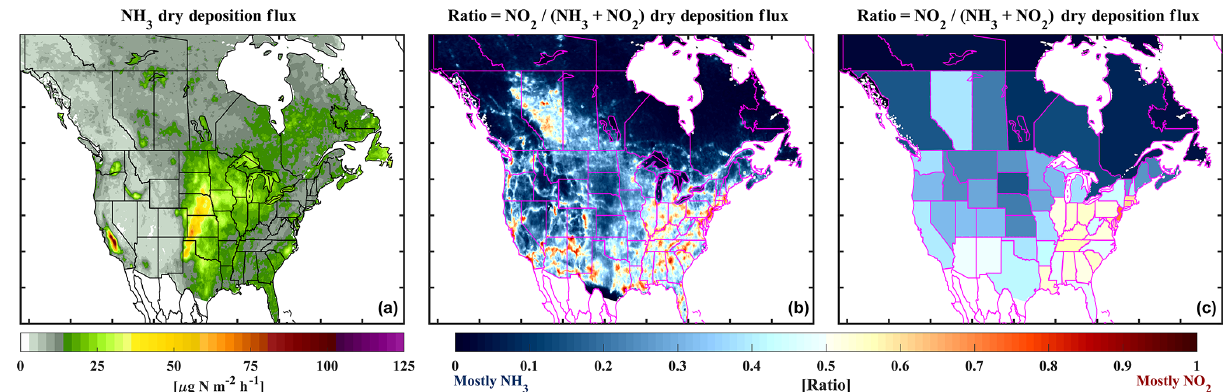
Figure 13. The 2013 plots of the CrIS satellite-derived dry deposition flux of reactive nitrogen. From (a) to (c) this figure contains plots of dry deposition from NH 3 and the relative ratio of NO 2 to (NH 3 + NO 2 ), with this ratio averaged over geopolitical boundaries.